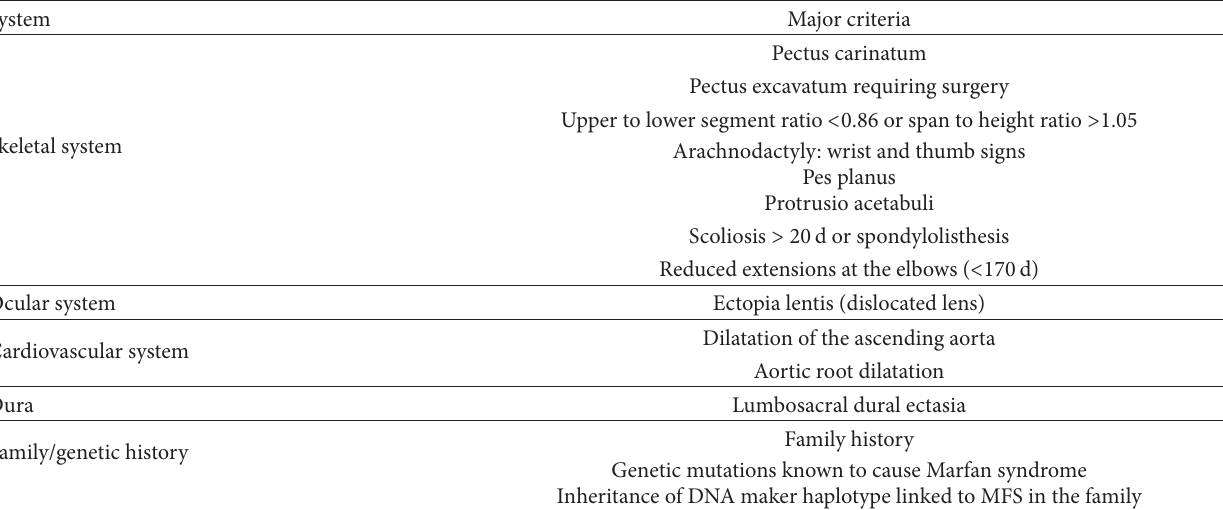
T 2: Major Ghent criteria used to diagnose Marfan